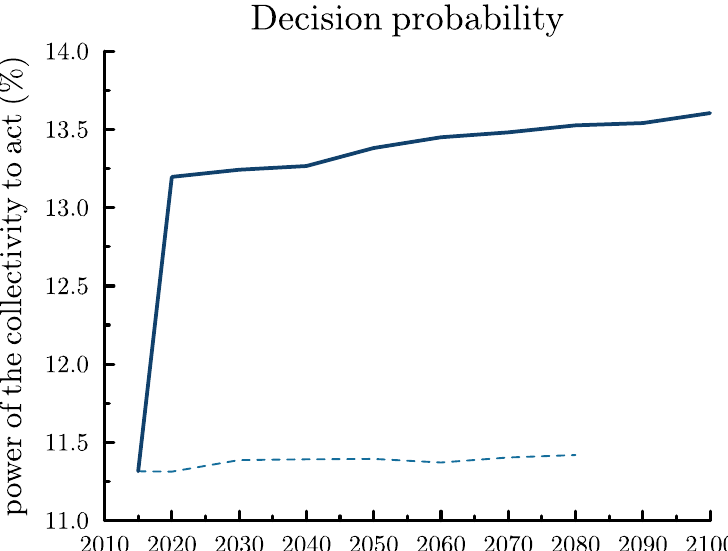
Figure 3. Predictions for the power of a collectivity to act for the European Union. Dashed and solid lines, respectively, show the 2014 pre-Brexit status quo and 2019 Brexit